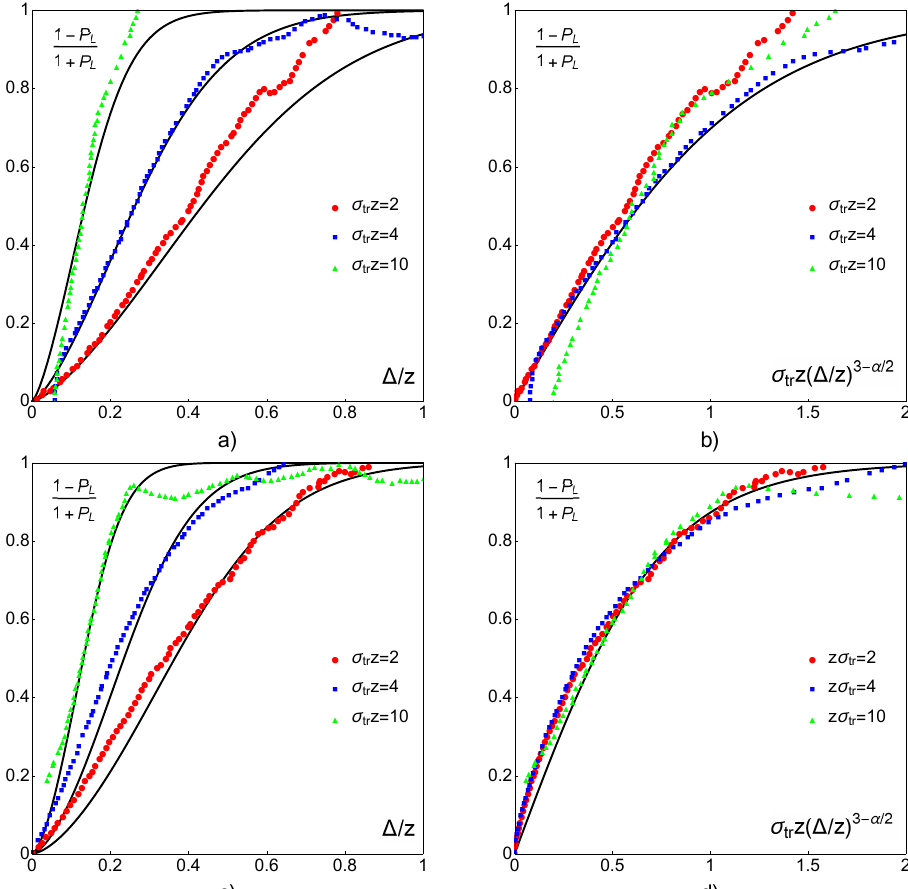
Figure 11. Depolarization ratio ( 1 − P L )/( 1 + P L ) as a function of dimensionless variables. Symbols ( — σ tr z = 2, ∎ — σ tr z = 4, ▲ — σ tr z = 10) are the results of Monte Carlo simulations [17] for aqueous suspension of polystyrene spheres of diameter 0.993 µ m ( a , b ) and 0.3 µ m ( c , d ). Solid lines are the results of our calculations for α = 3.24 ( a , b ) and α = 2.85 ( c , d